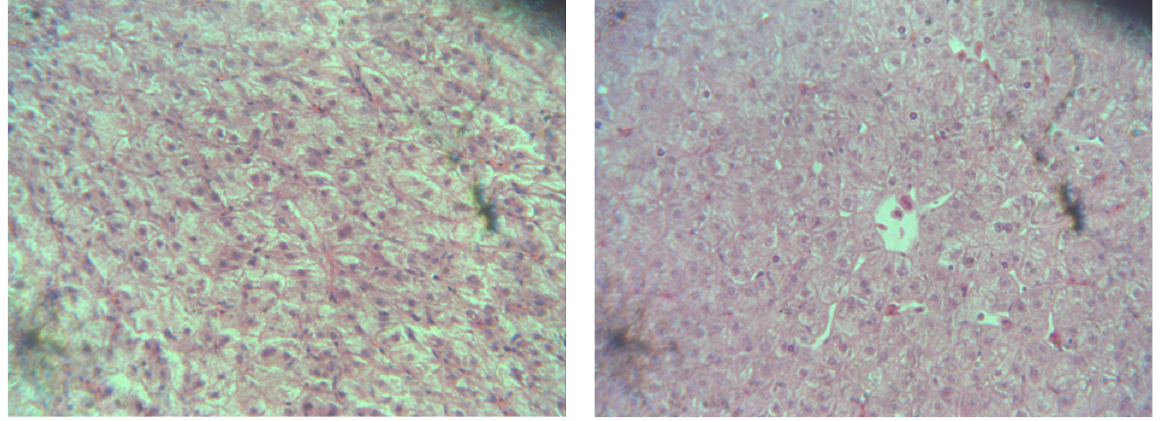
Fig. 4. Group D H&E X400 LIVER normal hepatocytes showing central